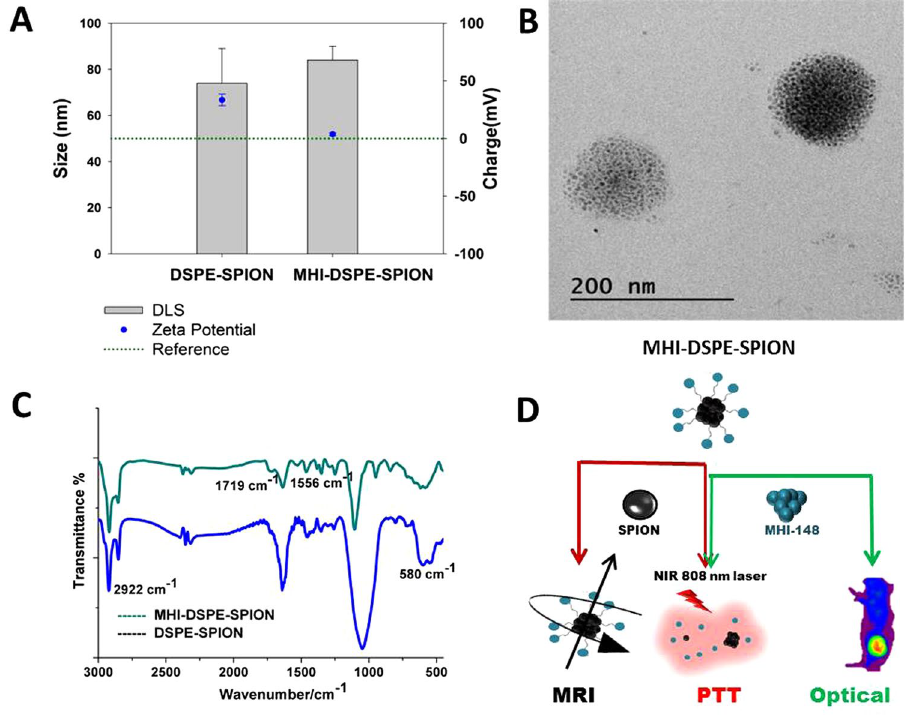
Figure 2. Physicochemical properties of MHI-DSPE-SPION and DSPE-SPION. ( A ) Surface charge and hydrodynamic size, as measured by zeta potential and DLS analysis, respectively. ( B ) MHI-DSPE-SPION morphology, as observed by TEM ( C ) FT-IR was done in the spectral range between 800 and 3000 cm − 1 for DSPE-SPION and MHI-DSPE-SPION to analyze the bonding between DSPE-SPION and the MHI-148 dye. ( D ) Illustration describing the role of SPION and MHI-148.